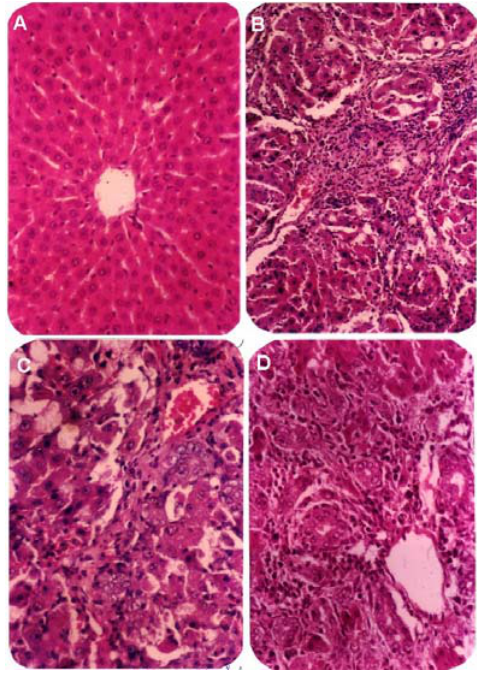
FIGURE 1. Section of liver from (A) an untreated control (normal) rat showing normal histological structure of hepatic lobules and central veins; (B) CCl 4 -treated rat showing marked fibrosis (arrow), the fibrous tissue runs in septa between the nodules. Many pesudolobules could be noticed; (C) CCl 4 and silymarin-treated rat showing moderate fibrosis, vacuolar degeneration, haemorrhagic area, but no cirrhosis; (D) CCl 4 and biphenyldimethyldicarboxylate (DDB) (3 mg/kg)-treated rat showing marked fibrosis and cirrhosis (H & E x